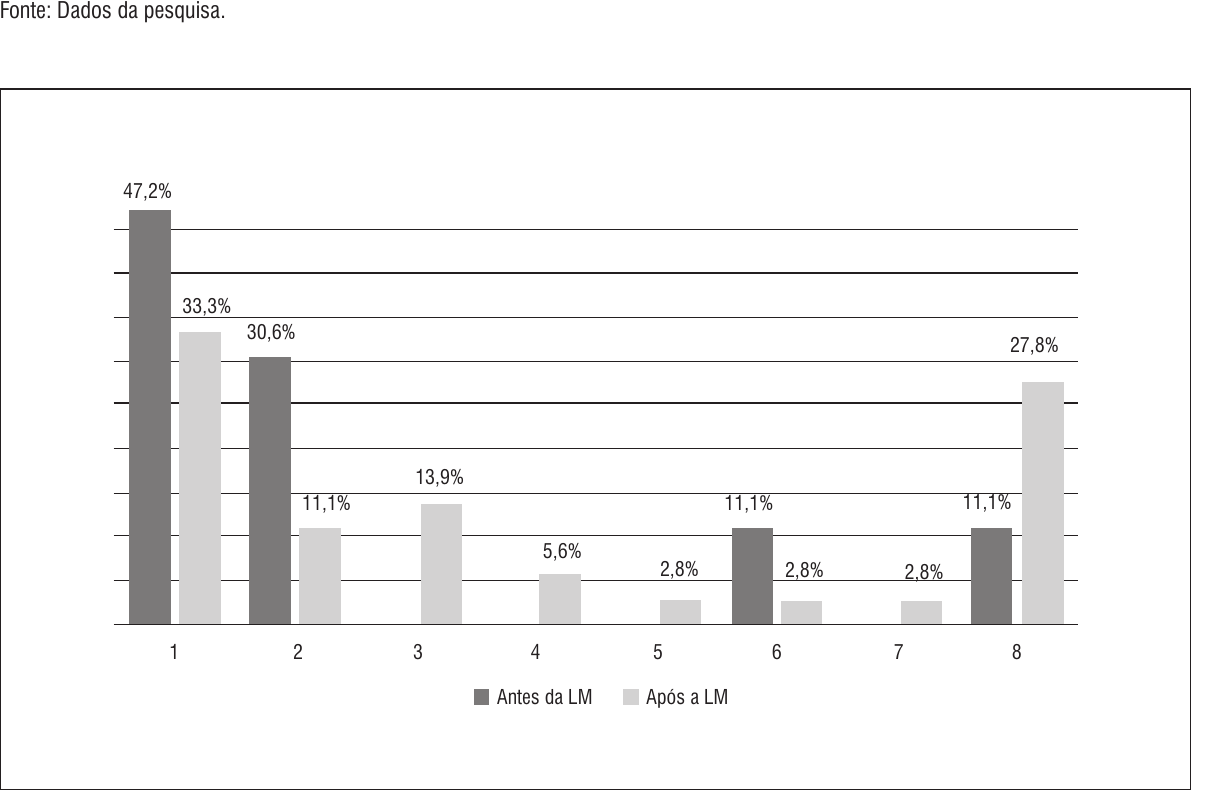
Figura 1 - Sensações apresentadas durante o ato sexual antes e após a LM Legenda: 1 - Aumento da frequência cardíaca, respiratória e temperatura corporal; 2 - Aumento da frequência cardíaca, respiratória e temperatura corporal e arrepio; 3 - Aumento da frequência cardíaca, respiratória e temperatura corporal, arrepio e espasticidade; 4 - Aumento da frequência cardíaca, respiratória e temperatura corporal e espasticidade; 5 - Aumento da frequência cardíaca, respiratória e temperatura corporal, espasticidade e dor; 6 - Arrepio; 7 - Arrepio e espasticidade; 8 - Nenhuma. Fonte: Dados da